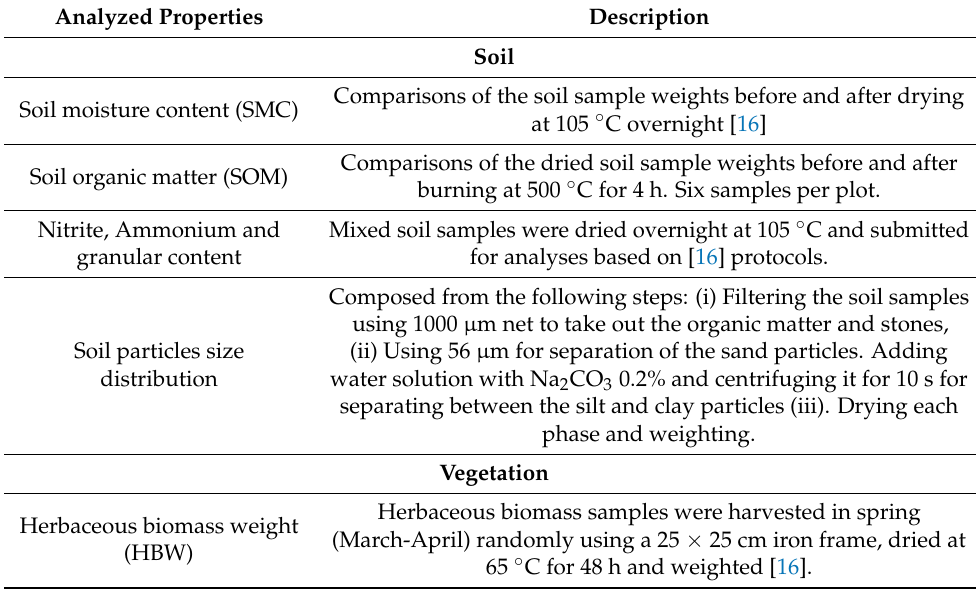
Table 2. The physical, chemical and vegetal measurements were carried out in the